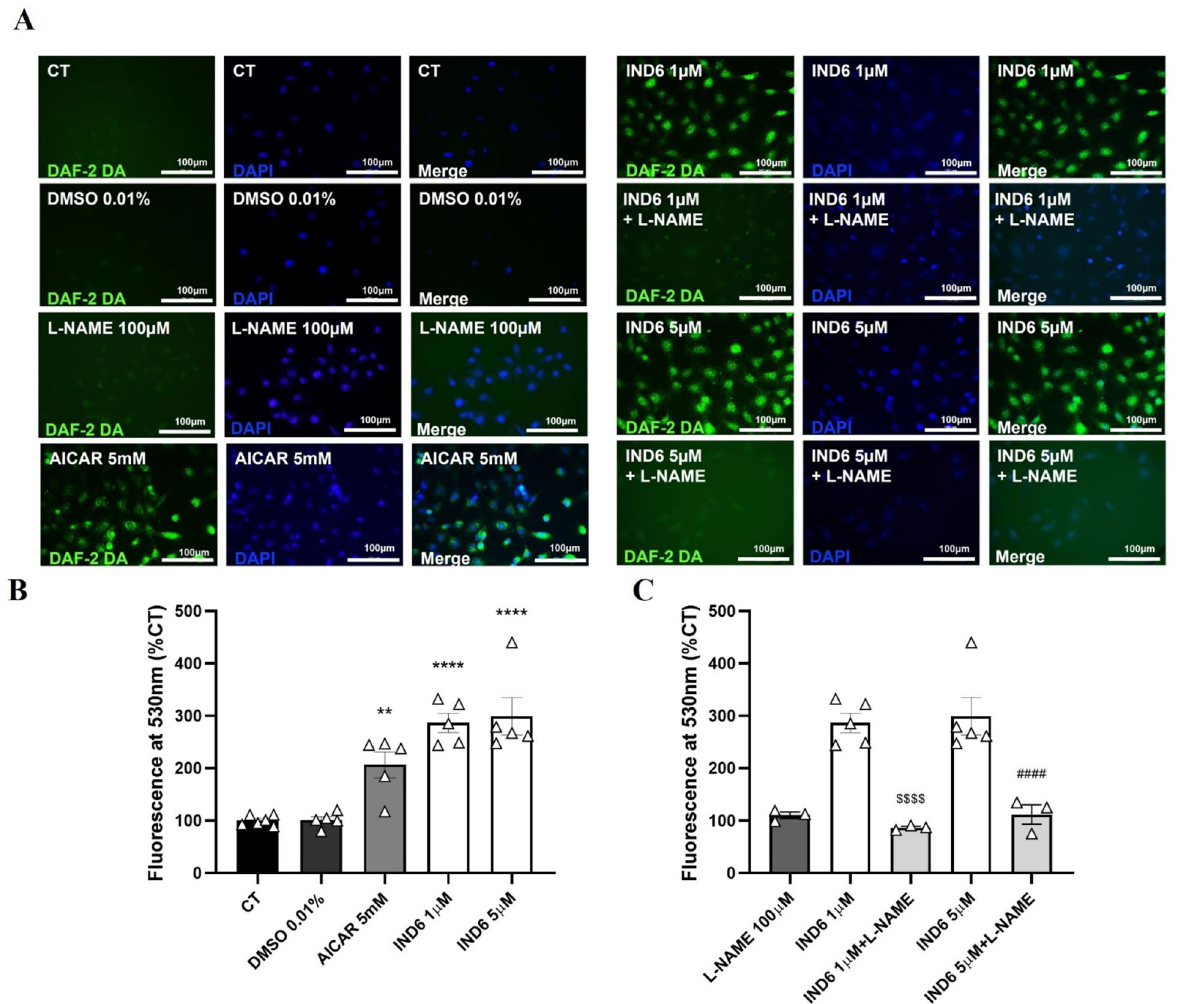
Figure 7. IND6 promotes an increase in DAF-2T fluorescence in human endothelial cells. ( A ) Representative fluorescence microscopy images of NO fluorescent indicator (DAF-2D incubation, first column left and right, green) and DAPI (second column left and right, blue) in cultured EA.Hy926 endothelial cells in basal conditions (CT) and after 60 min treatment with DMSO 0.01%, eNOS inhibitor L-NAME (100 μM), AMPK activator AICAR (5 mM), IND6 (1 and 5 μM) and IND6 (1 and 5 μM) + L-NAME (100 Μm). (n = 3–5). ( B ) Bar chart of the quantification of the intensity of green fluorescence (530 nm.) by densitometry represented as the percentage with respect to the control cells. **p < 0.01 vs. CT and ****p < 0.0001 vs. CT; n = 3–5. ( C ) Bar chart of the quantification of the intensity of green fluorescence (530 nm) by densitometry represented as the percentage with respect to the control cells. $$$$ p < 0.0001 vs. IND6 1 μM and #### p < 0.0001 vs. IND6 5 μM; n = 3–5. The data are presented as means ±